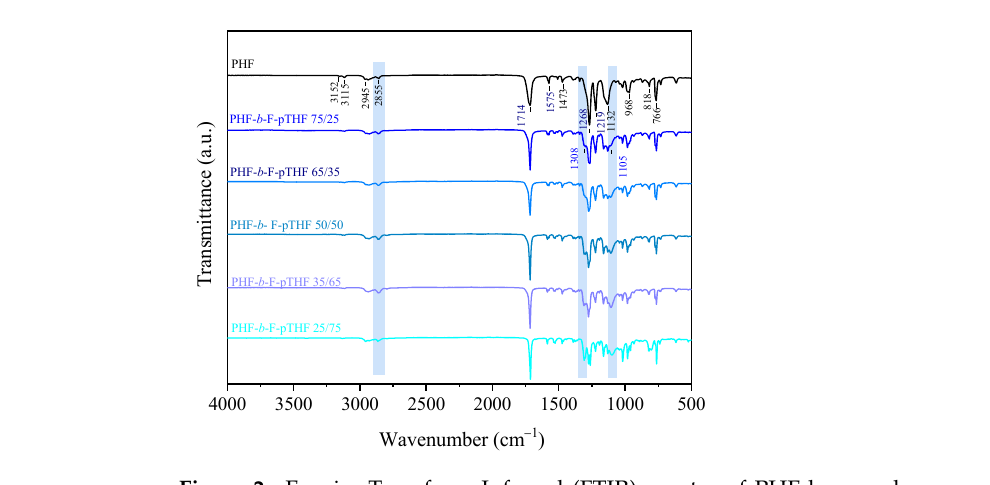
Figure 2. Fourier Transform Infrared (FTIR) spectra of PHF homopolymer and PHF- b -F-pTHF copolymers.